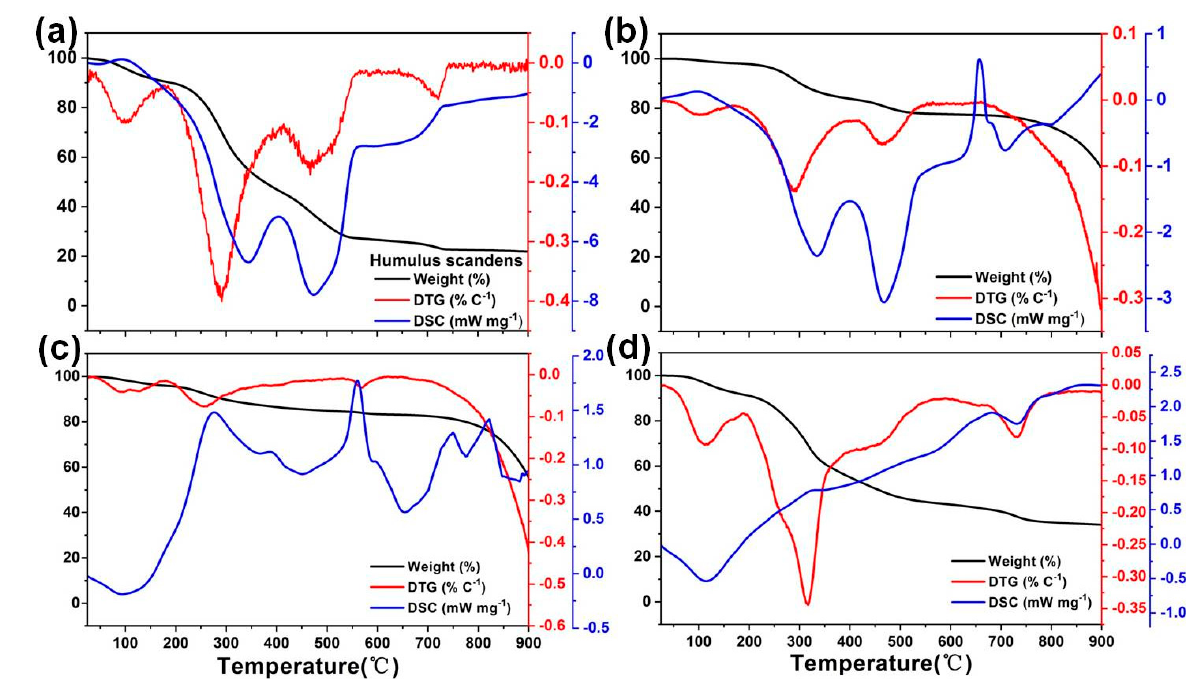
Figure 1. TG, DTG and DSC pyrolysis curves for ( a ) pure HS, ( b ) HS and salt and ( c ) HS with salt and NaOH in the air; ( d ) the pyrolysis of HS under N 2 protection.